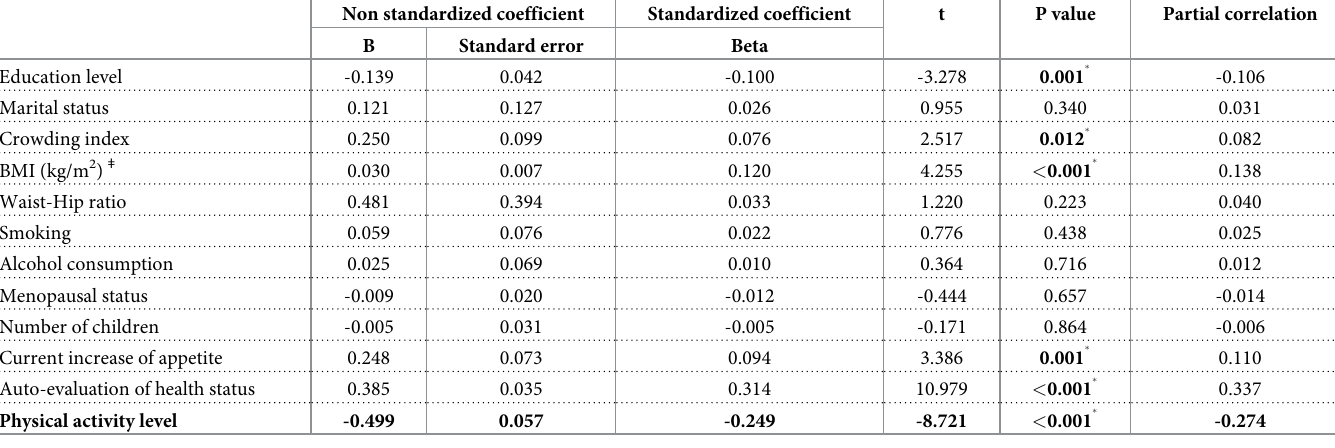
Table 8. Multiple regression of factors associated with the physical